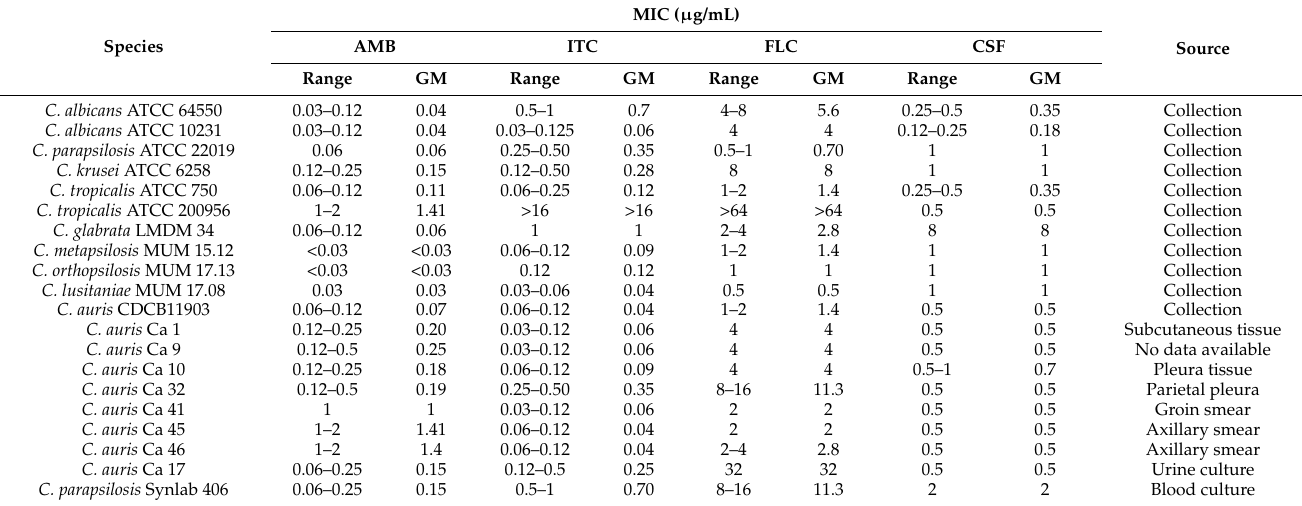
Table 2. Minimal inhibitory concentration values of the most active EOs studied and of some commercial terpenes against Candida